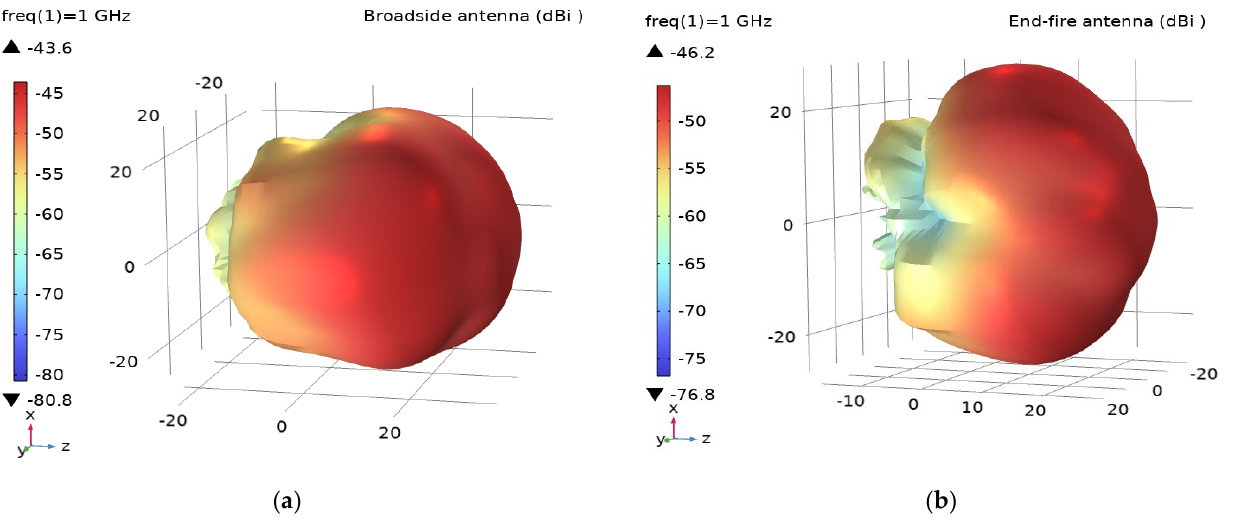
Figure 5. Three-dimensional radiation patterns of antenna: ( a ) 3D radiation patterns of the broadside antenna; ( b ) 3D radiation patterns of the end-fire antenna.